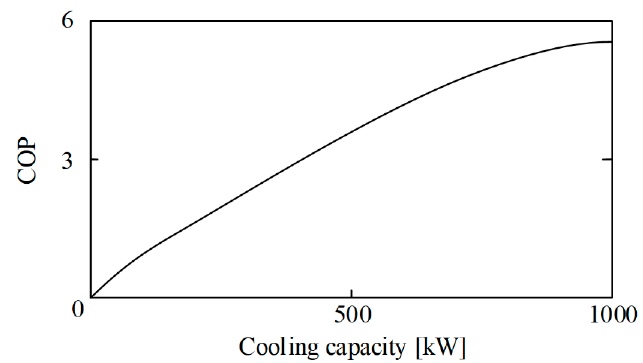
Figure 2. Theoretical cooling capacity—slide valve curve of a screw compressor.